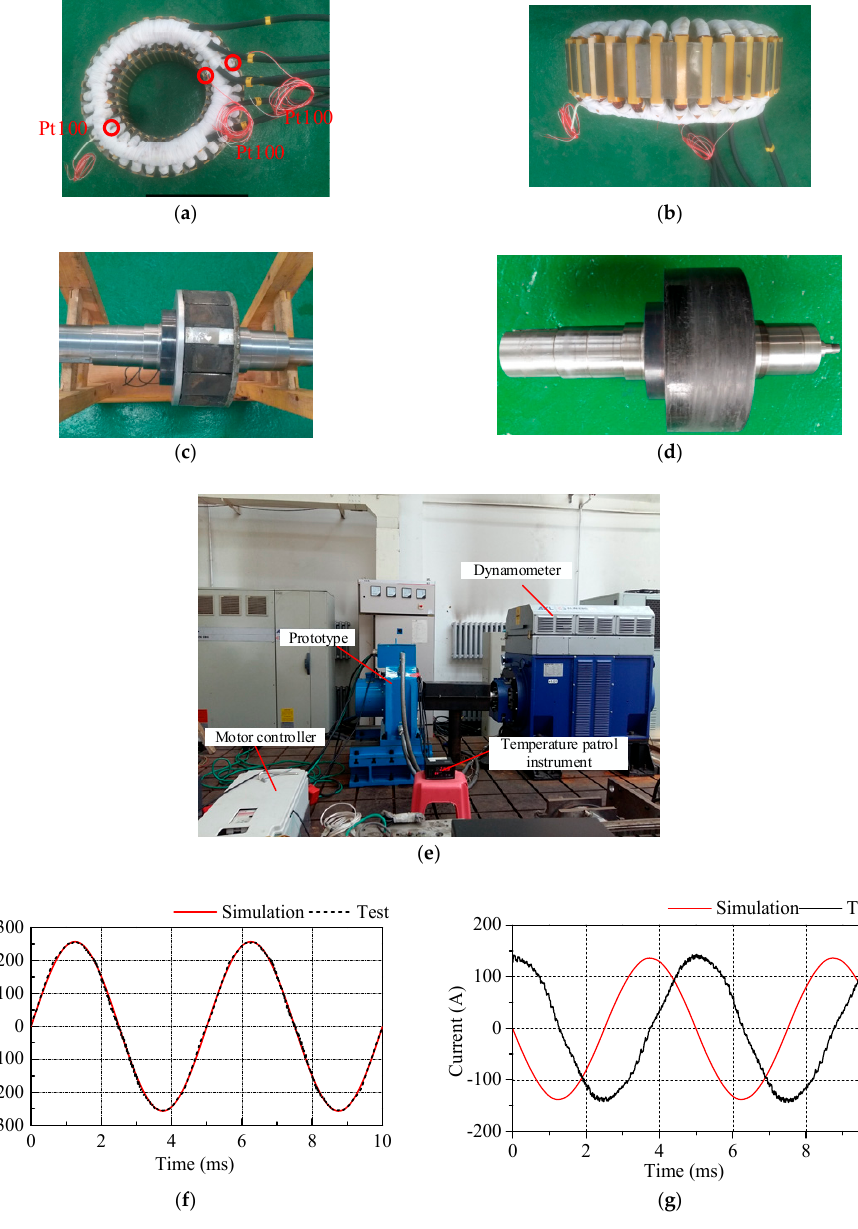
Figure 14. Configurations of ( a , b ) stator of the prototype; ( c ) rotor with magnets mounted; ( d ) rotor after retaining sleeve mounted; ( e ) a photograph of the complete experimental setup; waveforms of ( f ) no-load back EMF; ( g ) rated current of prototype at 6000 rpm.